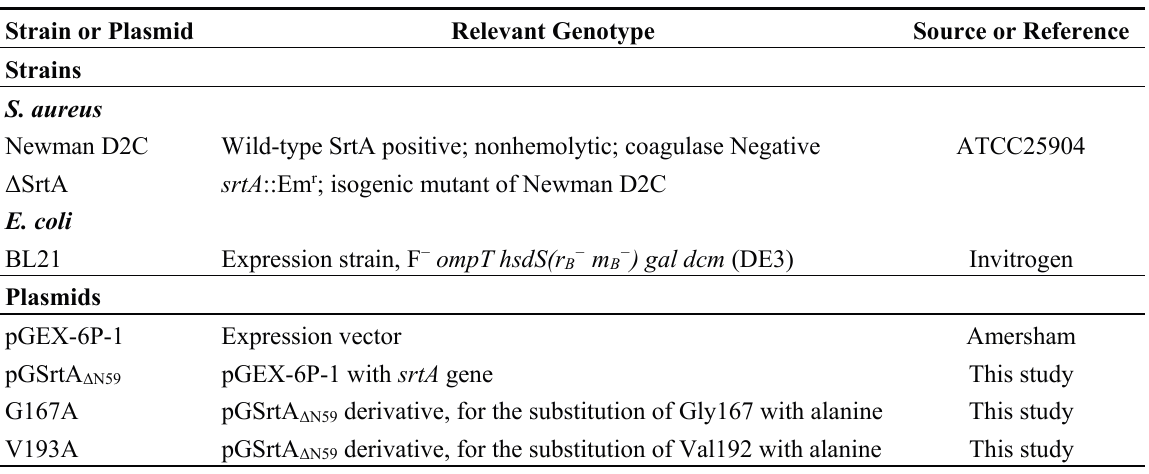
Table 3. Strain and plasmid